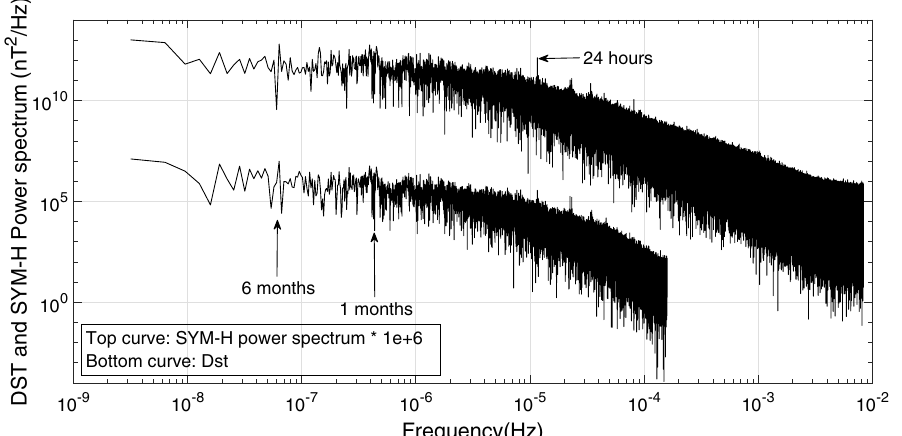
Top curve: SYM-H power spectrum * 1e+6 Bottom curve: Dst